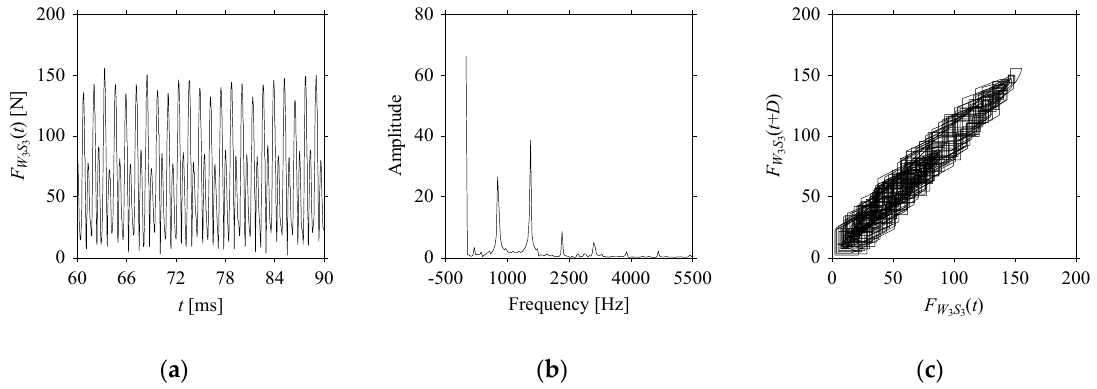
Figure A12. F W in the form of: ( a ) time series, ( b ) fast Fourier Transformation (FFT), and ( c ) delay map ( d = 1). 3 S 3